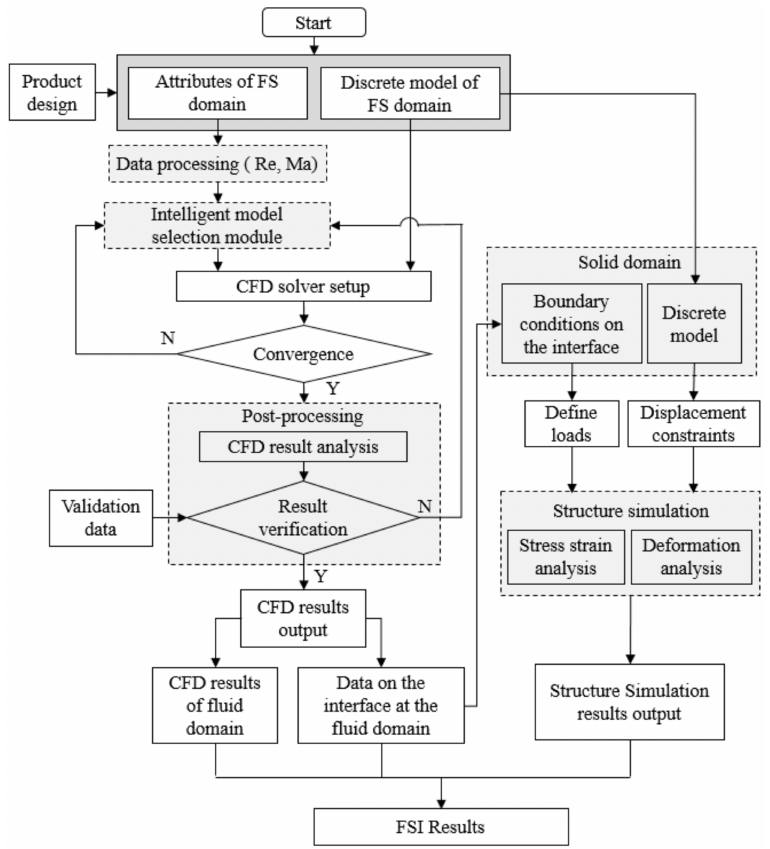
Figure 2. Structure of the intelligent FSI simulation